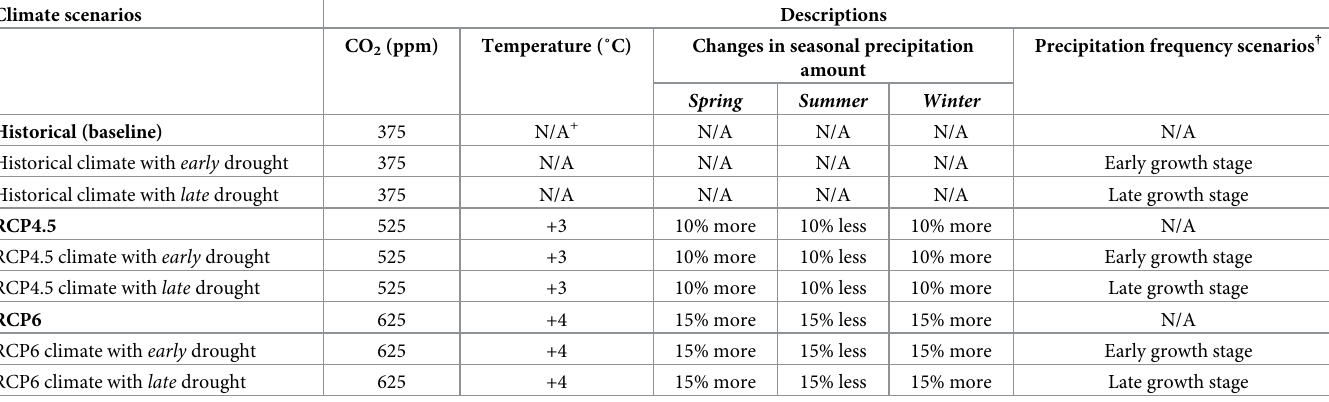
Table 1. Descriptions of the climate scenarios in the